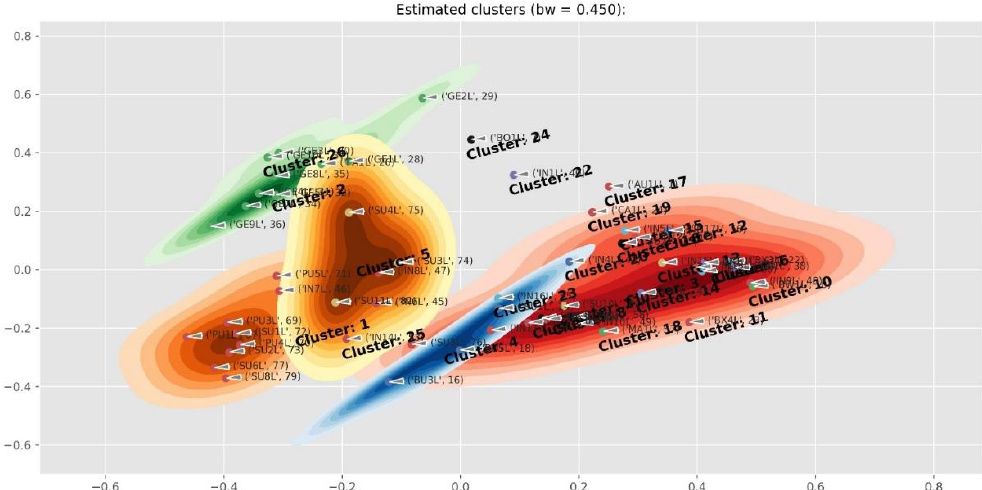
Figure 6. Cluster map of only the leaf samples of Cyclopia species with mangiferin excluded, showing an improved separation of the main cluster in Figure 5. Note, for example, that the C. genistoides samples now form a cluster 2 (shown in green). C. aurescens (AU), C. bolusii (BO), C. bowiena (BW), C. burtonii (BU), C. buxifolia (BX), C. capensis (CA), C. falcata (FA), C. genistoides (GE), C. glabra (GL), C. intermedia (IN), C. maculata (MA), C. meyeriana (ME), C. plicata (PL), C. pubescens (PU) and C. subternata (SU)